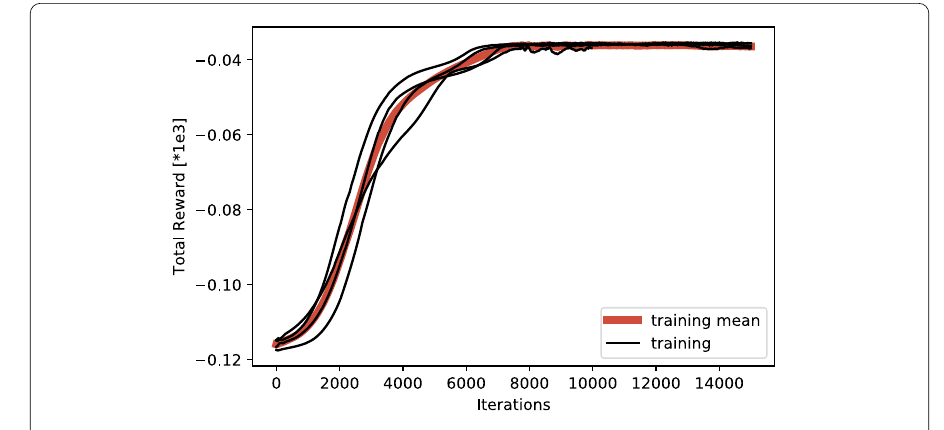
Figure 6 The summed up reward during the